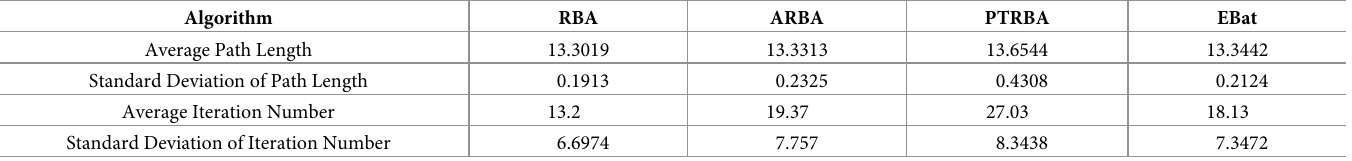
Table 3. Performance comparison between RBA and BA variants in test case 1.